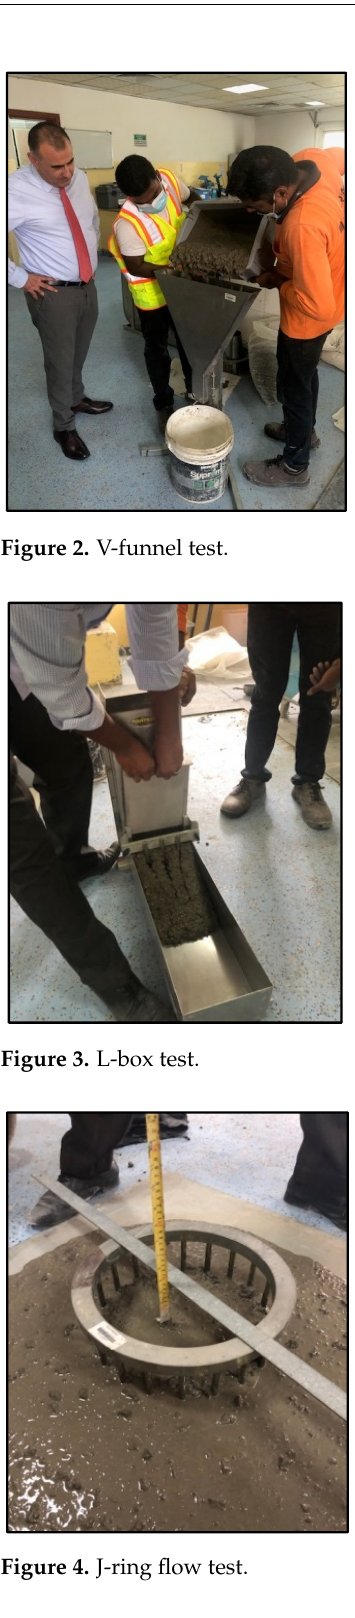
Figure 5. Water absorption test device.